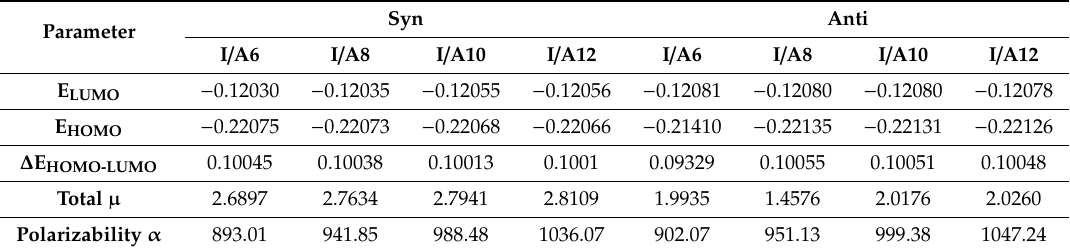
(Figure 4). The negatively charged atomic sites (the red region) were estimated to be localized on carboxylate moiety of the alkoxy azo acid, while the moiety of the dinitrogen base as well as the alkyl chain were predicted to show the least negatively charged atomic sites (blue regions). As shown in Figure 4, the orientation of the charges was a ff ected by the orientation of the nitrogen atoms of the base I, and consequently, this could a ff ect the variation of the mesophase with the orientation of the dinitrogen